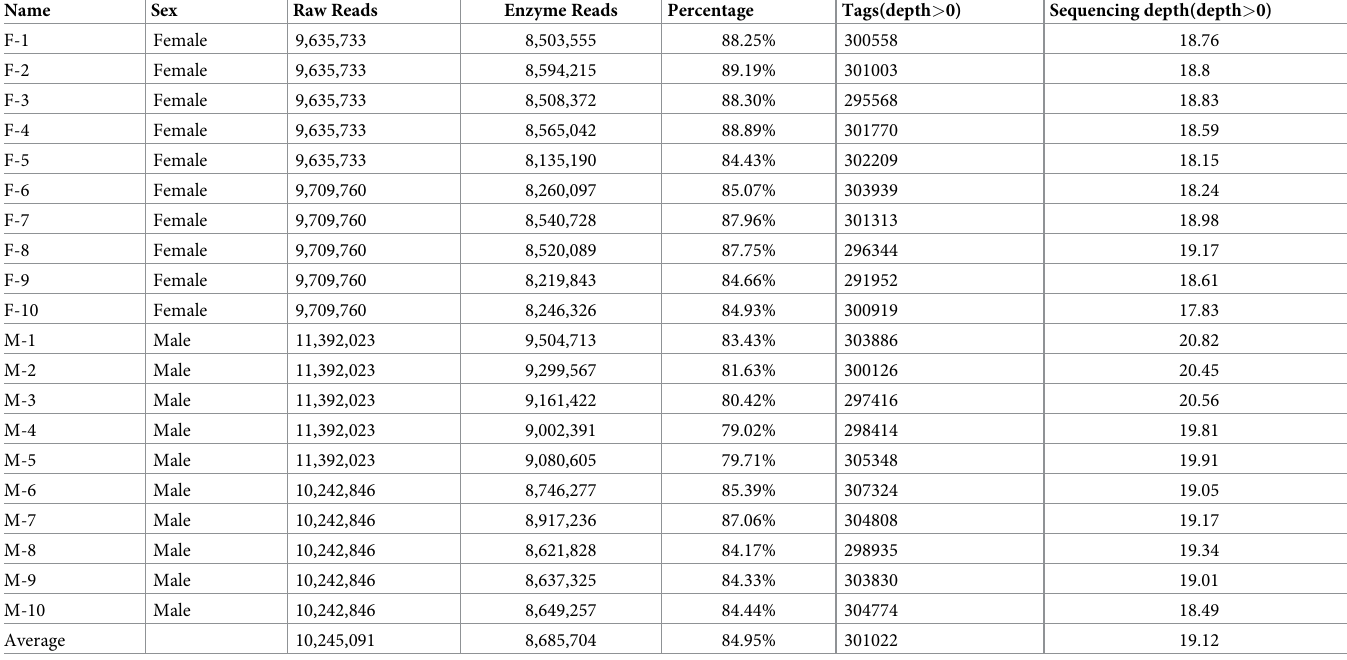
Table 1. Summary of 2b-RAD data obtained from 20 Alosa sapidissima